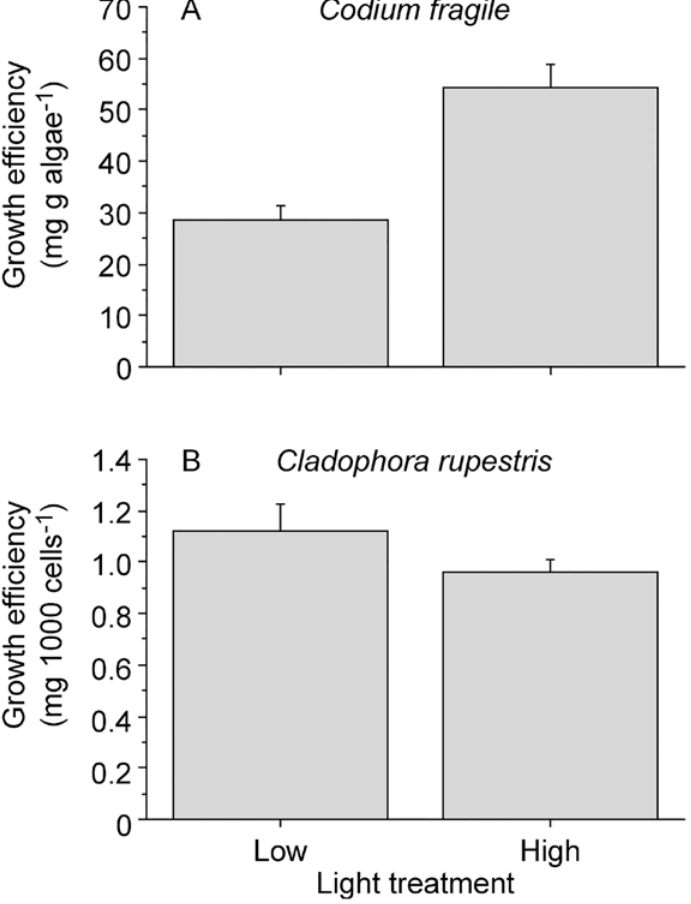
Fig 1. Growth efficiency of Elysia viridis from A) Codium fragile (mg per g algae) and B) Cladophora rupestris (mg per 1000 algal cells consumed) fed their original algal host diets under low and high light at the end of four-week experiments. Error bars show + SEM (n =